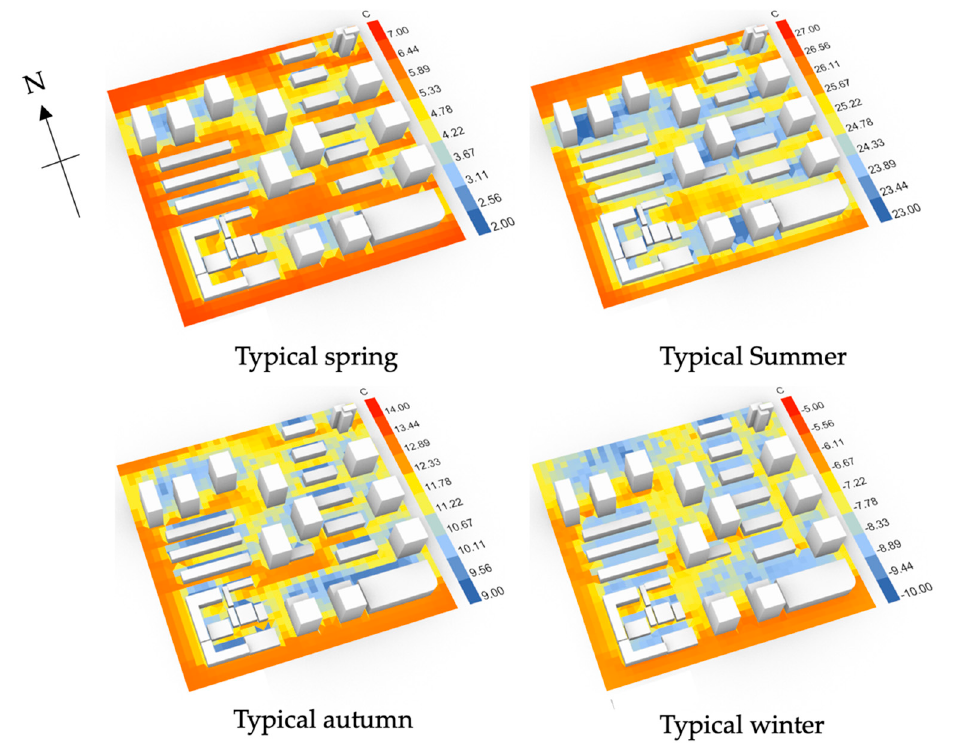
Figure 3. Digital simulation results of Sanlihe neighborhood.